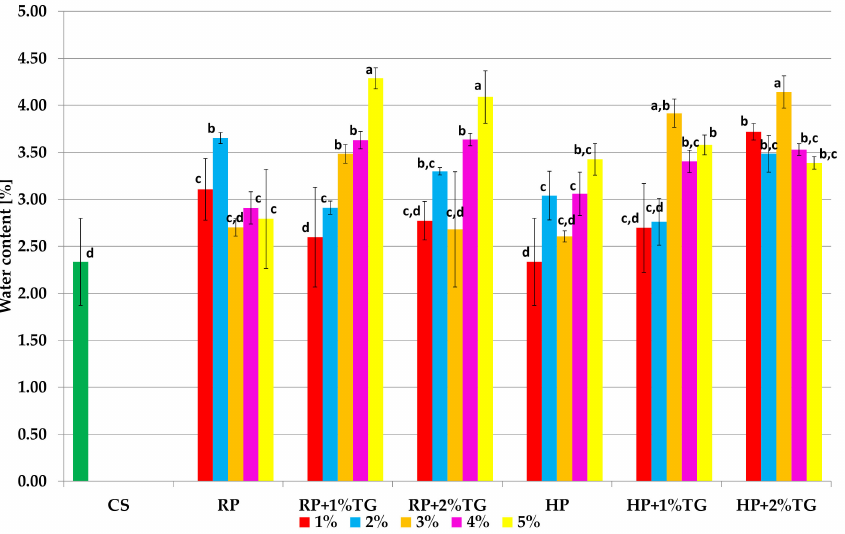
Figure 1. Average values of water contents in instant noodles with the additions of rice protein, hemp protein and TGase (CS—control sample, RP—rice protein, RP+1%TG—rice protein with 1% TGase, RP+2%TG—rice protein with 2% TGase, HP—hemp protein, HP+1%TG—hemp protein with 1% TGase, HP+2%TG—hemp protein with 2% TGase). Columns correspond to various additions of rice protein. Mean values denoted by different letters ( a – d ) represent statistically significant differences between variables (water content and samples) ( p <